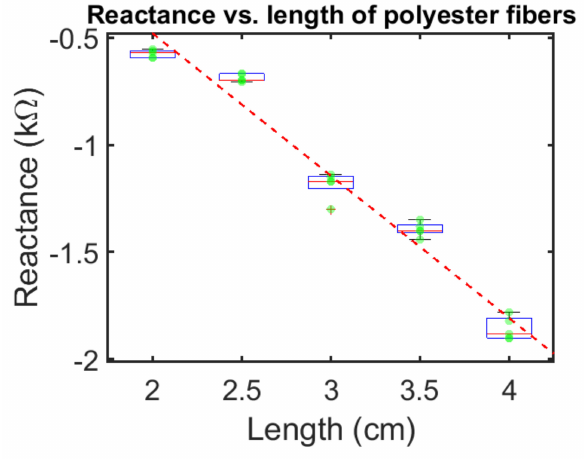
Figure 4. Reactance of polyester ECF measured at f = 1 MHz, five successive times, respectively, with respect to the fiber length. Box plot with box of first and third quartile and median, and whiskers of minimum and maximum values, not considering outliers. Outliers are denoted as “+”.